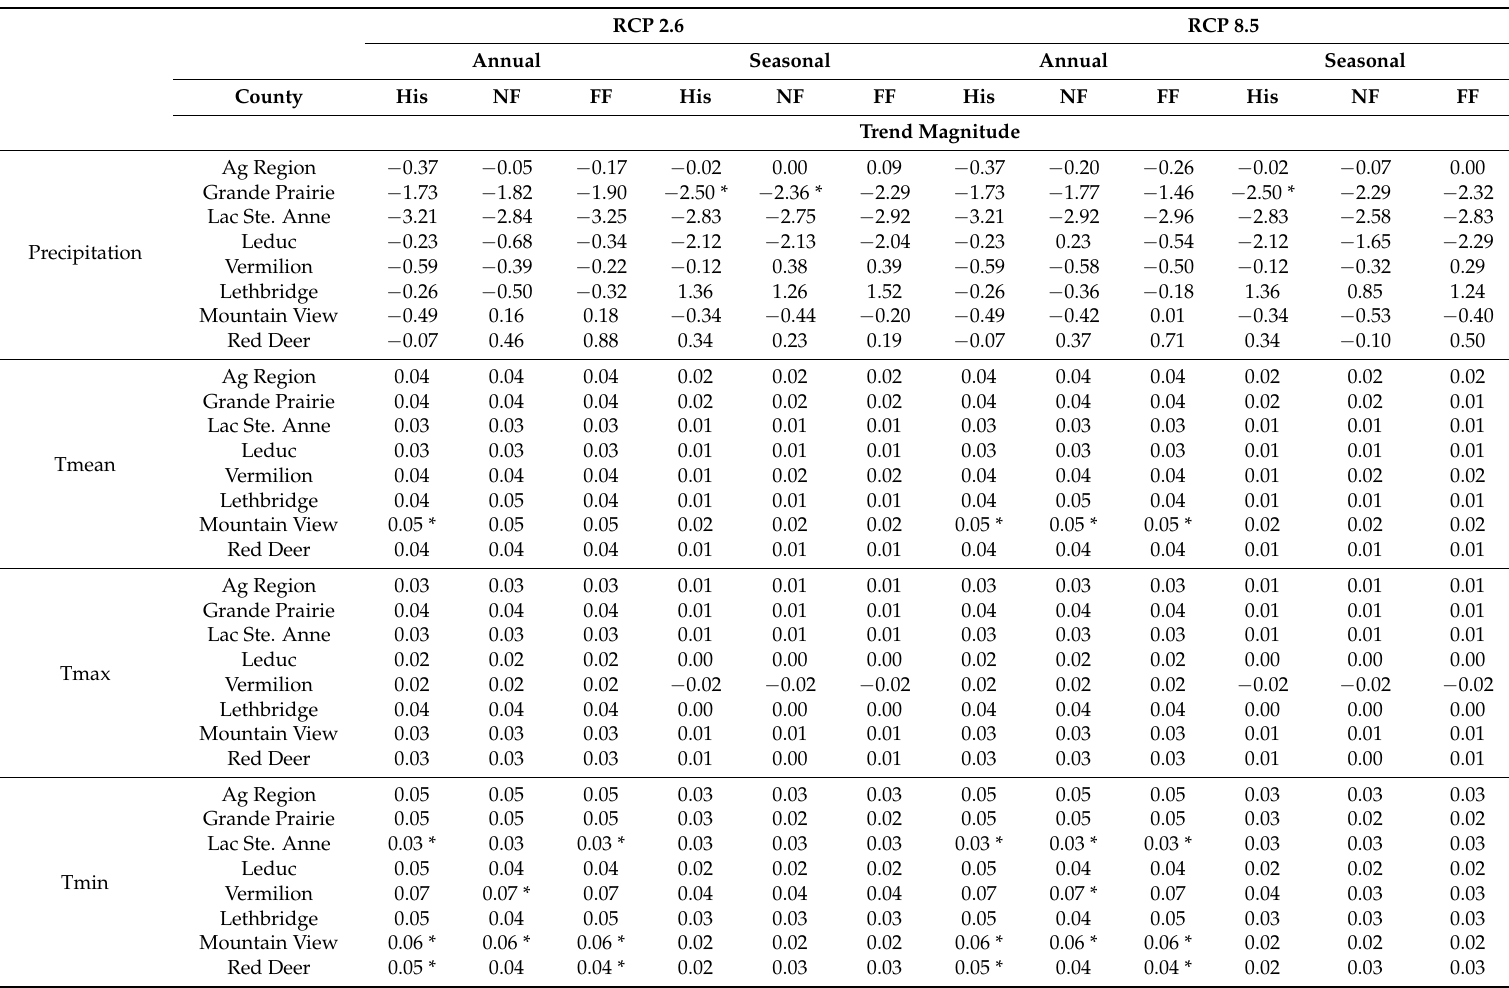
* indicates statistically significant at α = 0.05. ‘Ag Region’ indicates the entire study